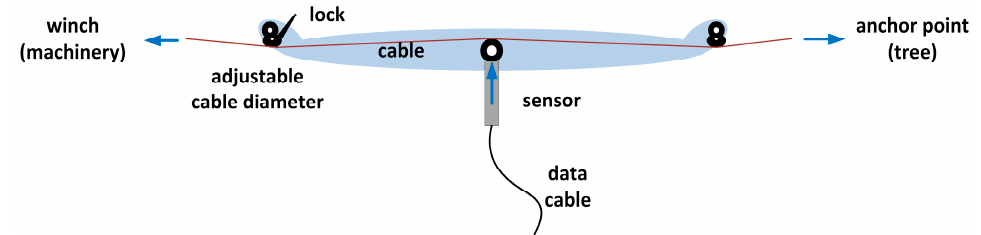
Figure 2. Simplified measuring principle for tensile forces, applied within the used CableBull device.